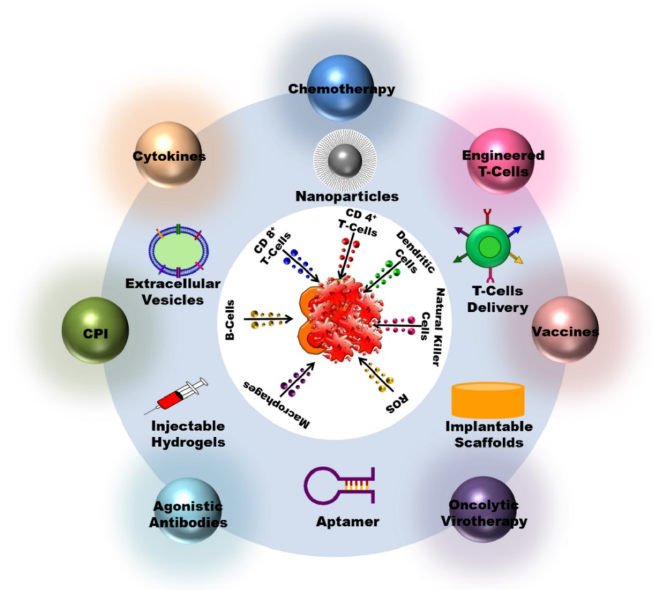
Figure 2. Efficient and effective delivery methods specific and less toxic to host cells used in cancer